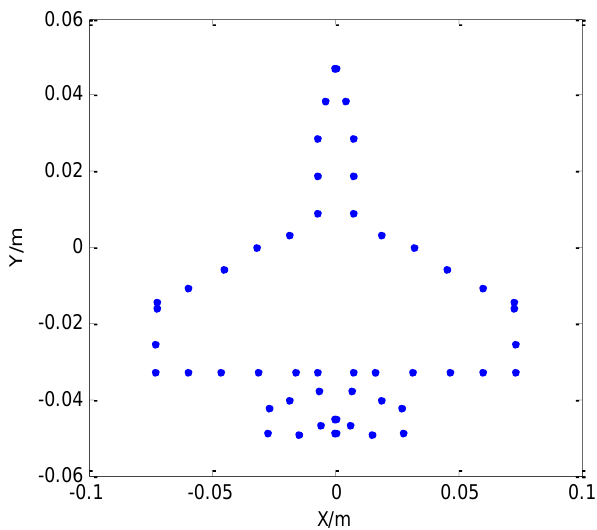
Figure 6. Simulation model of aircraft.